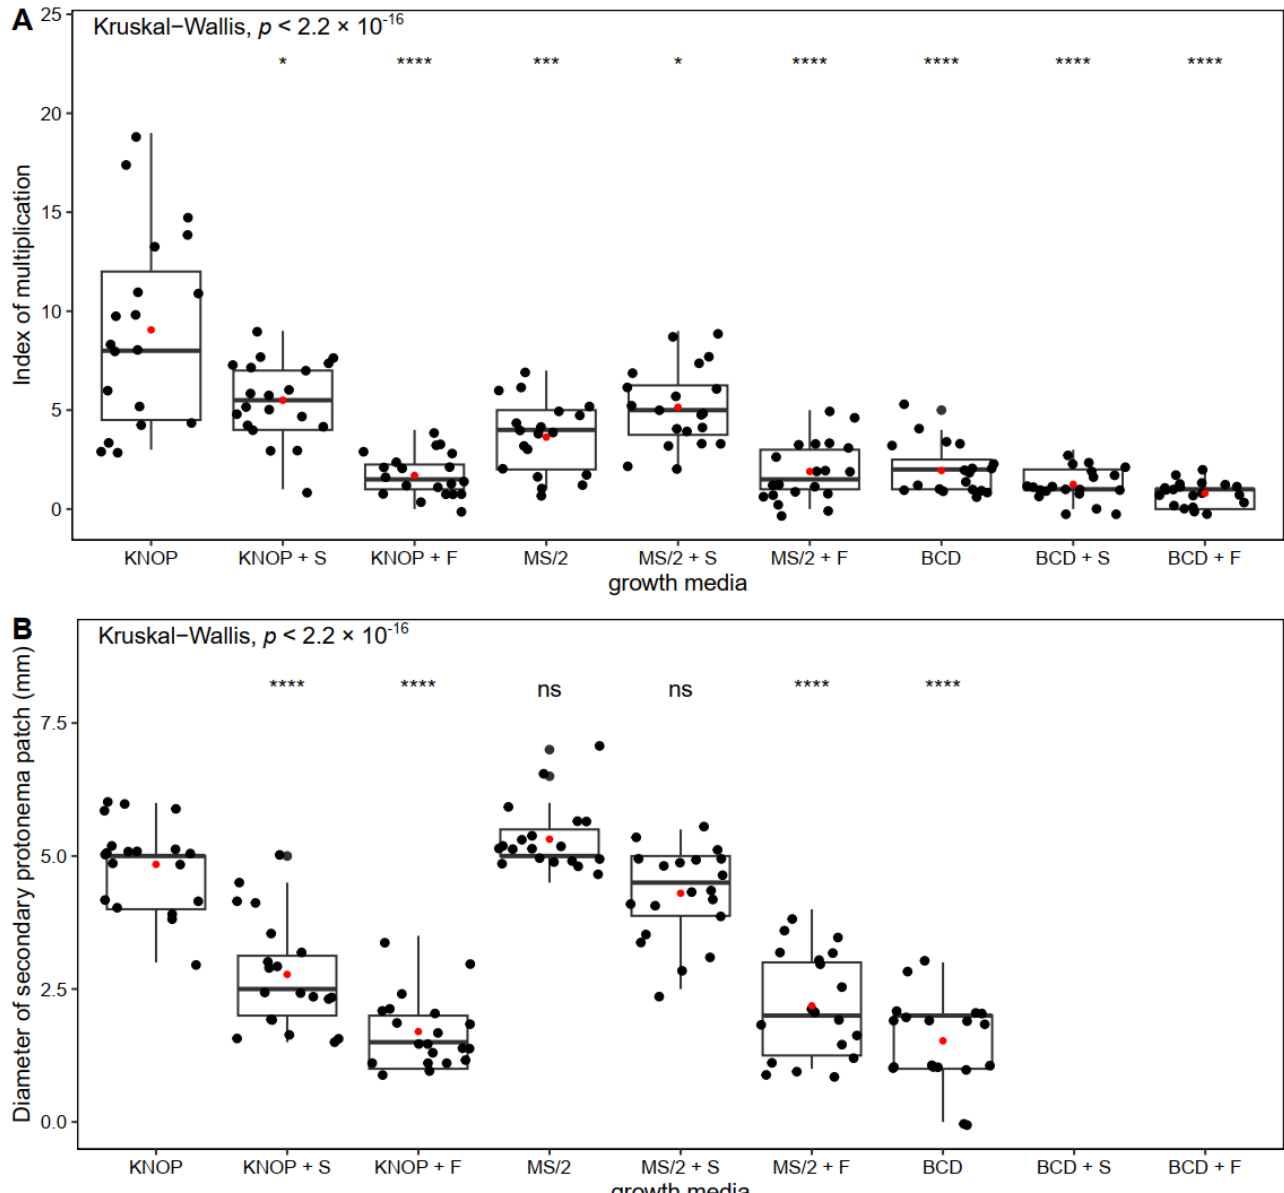
Figure 1. The index of multiplication ( A ) and secondary protonemal patch diameter ( B ) of Ptery- goneurum sibiricum on different nutrient media in Experiment type I. The box ranges from the first (Q1) to the third (Q3) quartile, with the black horizontal line representing the median. The black dots represent individual observations, while the red dots represent the mean. The whiskers extend to the 1.5 × IQR (interquartile range) from the edge of the box. Comparisons were made with the KNOP growth media as the reference group using the Wilcoxon rank-sum test * p ≤ 0.05; *** p ≤ 0.001; **** p ≤ 0.0001; ns— nonsignificant.